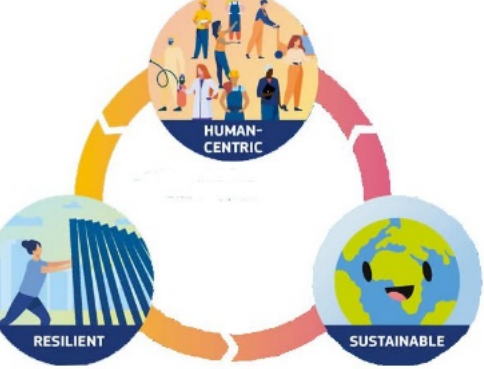
Figure 1. Three pillars of Industry 5.0 [2].